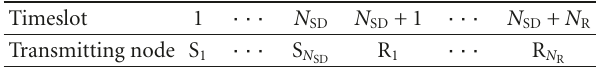
Table 2: Timeslots at which the nodes transmit their training sequences for channel estimation protocol